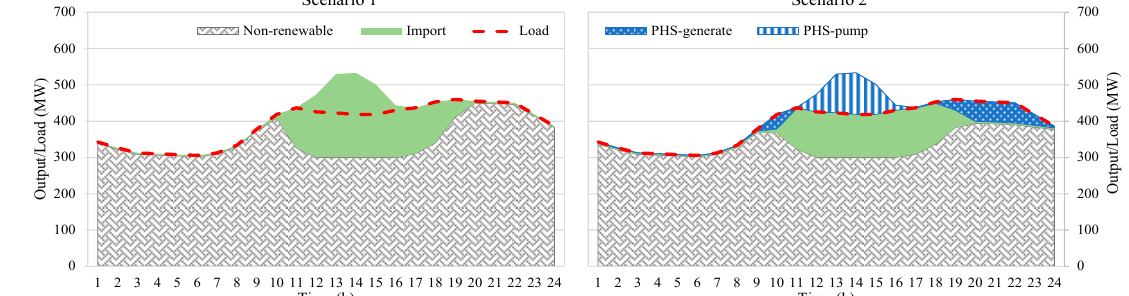
Table 3. Operation results of Scenario 1 and 2.